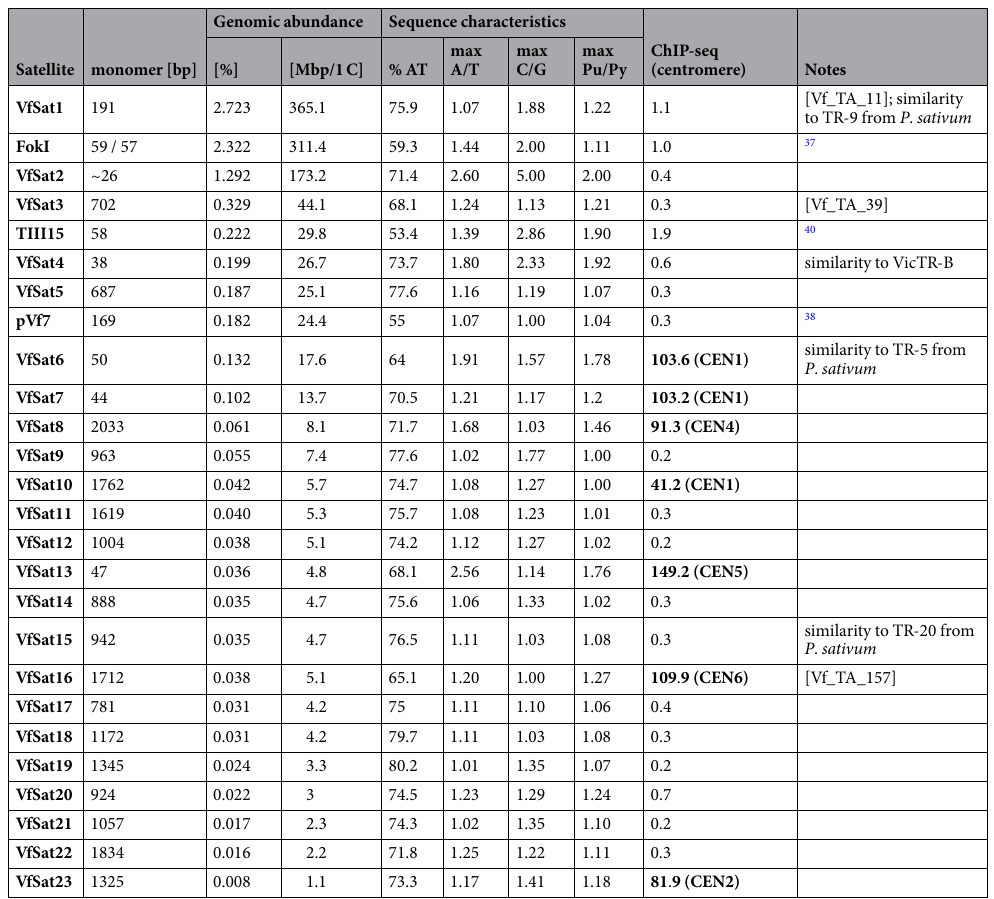
Table 1. Satellite repeats investigated in this study. Novel satellite repeats are numbered with the prefix “VfSat”; references to previously described repeats are given in Notes. Names in square brackets refer to homologous repeats that were partially characterized by Novák et al . 28 . The column “ChIP-seq” provides ChIP/input ratios; the values of significant enrichment are highlighted and supplemented with repeat localization determined by FISH. Sequences of all newly identified satellites are provided in Supplementary Data